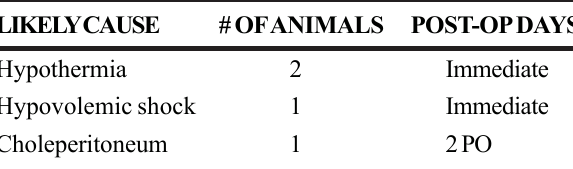
TABLE 6 - Observed sings in experiment animals SUBGROUP